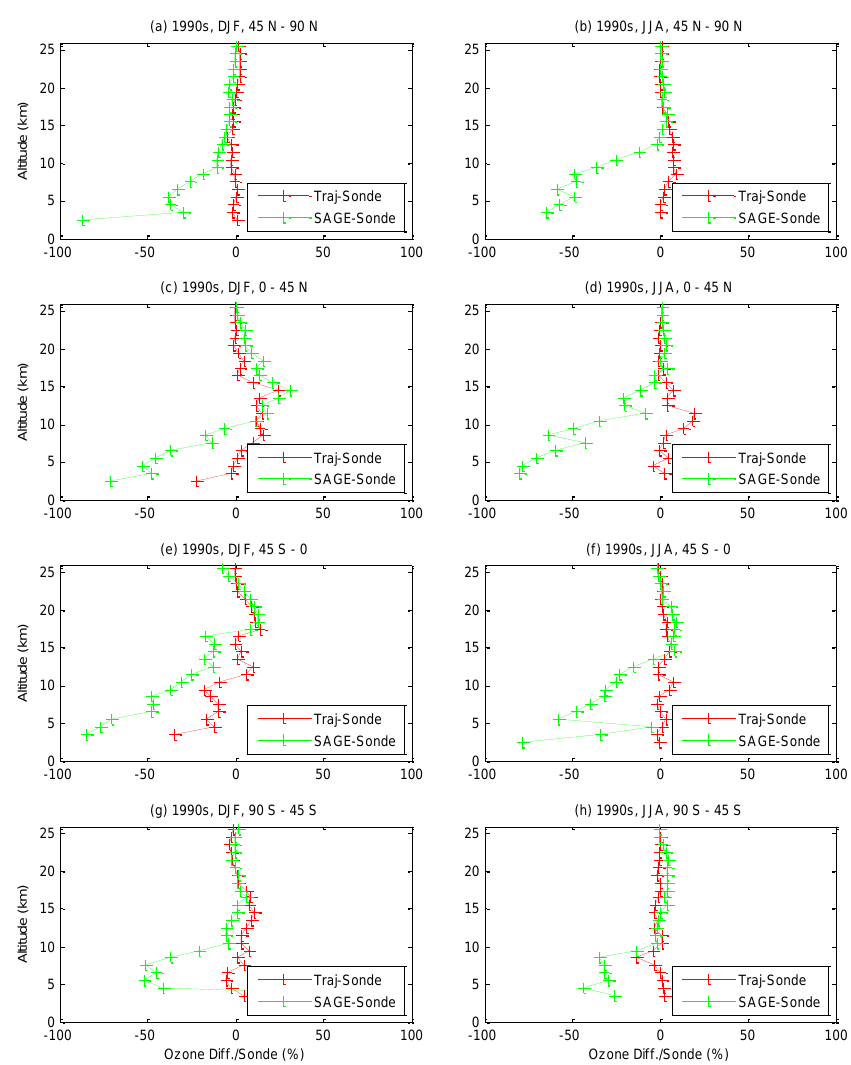
Fig. 4. Mean relative difference between the trajectory-derived ozone climatology and ozonesonde data (in red) for latitude zones 45–90 ◦ N, 0–45 ◦ N, 45 ◦ S–0 ◦ , and 90–45 ◦ S in NH winter (DJF, left panels) and summer (JJA, right panels) in the 1990s. Coincident SAGE and ozonesonde profiles are compared in green. See text for details.